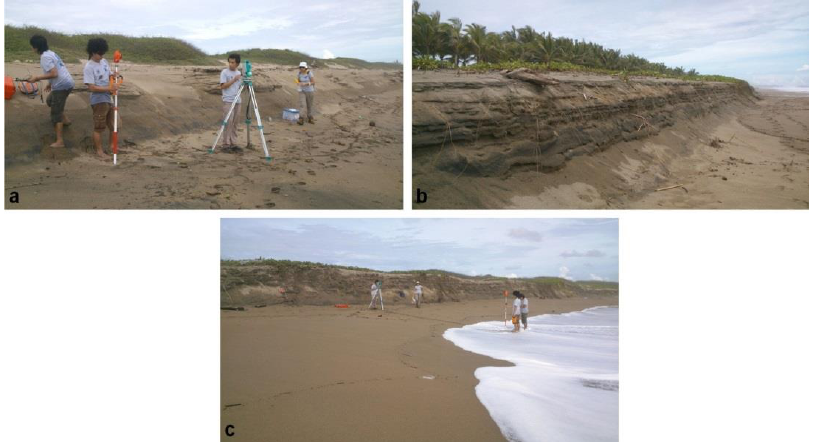
Figure 7. Dune scarps (steps) and vegetation cover at sections ( a ) S1 – S2, ( b ) S3 – S4, and ( c ) S5 – S6 after Hurricane Odile.